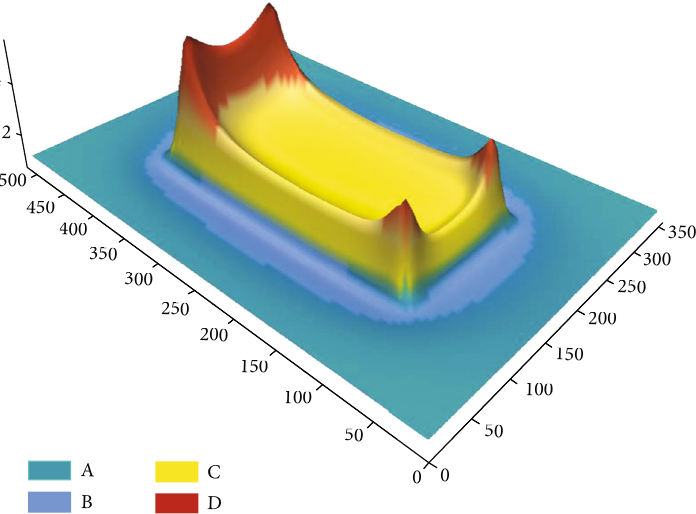
Figure 11: 3D diagram of bidirectional stress ratio zoning results.